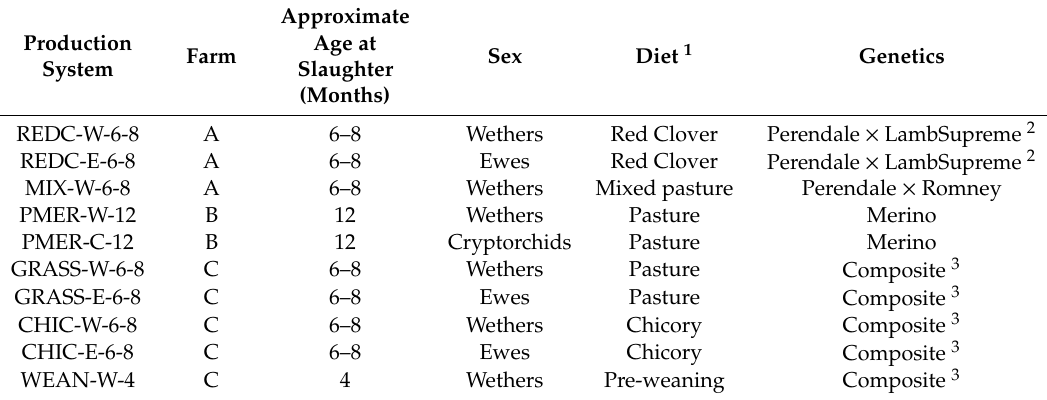
Table 1. Animal genetics, sex, diet and age at slaughter and distance to meat plant for Farms A, B and C ( n = 15 lambs per